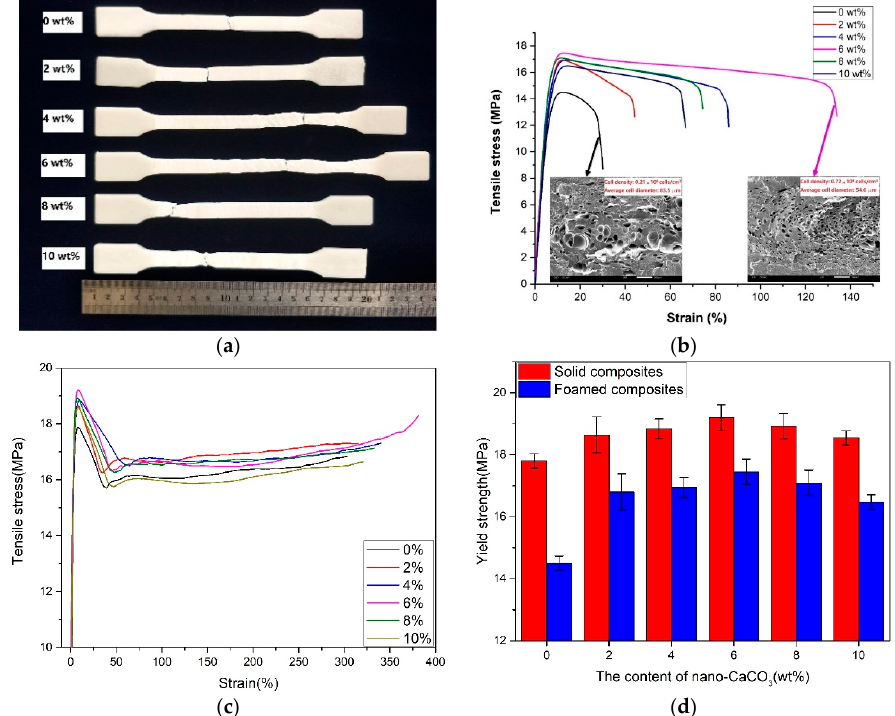
Figure 6. The results of the tensile tests are as follows: ( a ) the foamed samples after tensile testing; ( b ) the tensile stress–strain curves of foamed composites; ( c ) the tensile stress–strain curves of solid composites; and ( d ) the yield strength.